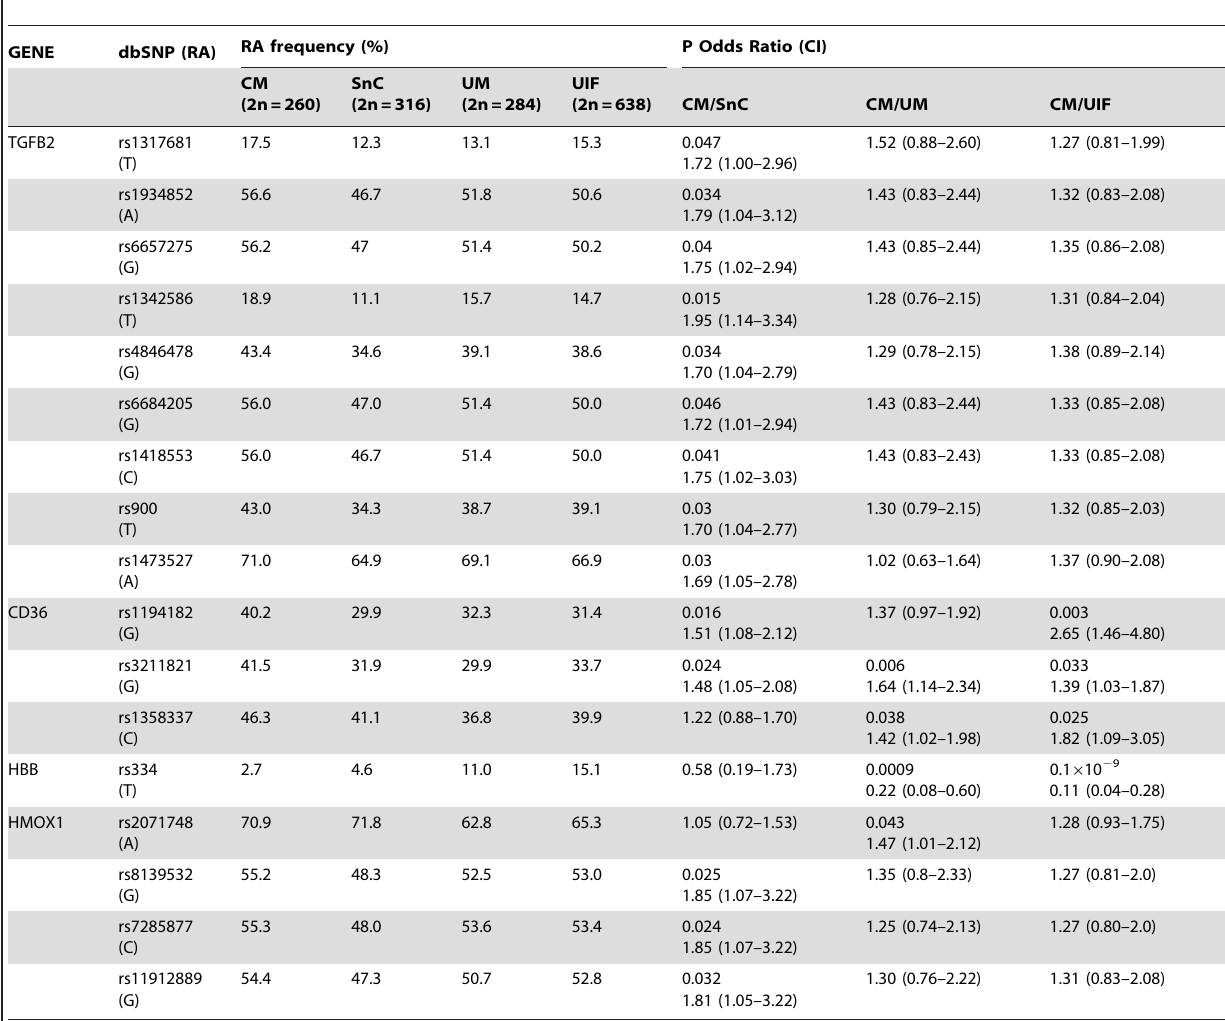
Table 1. Association results for cerebral malaria risk single-nucleotide polymorphisms (SNPs) genotyped in TGFB2 , CD36 , HBB and HMOX1